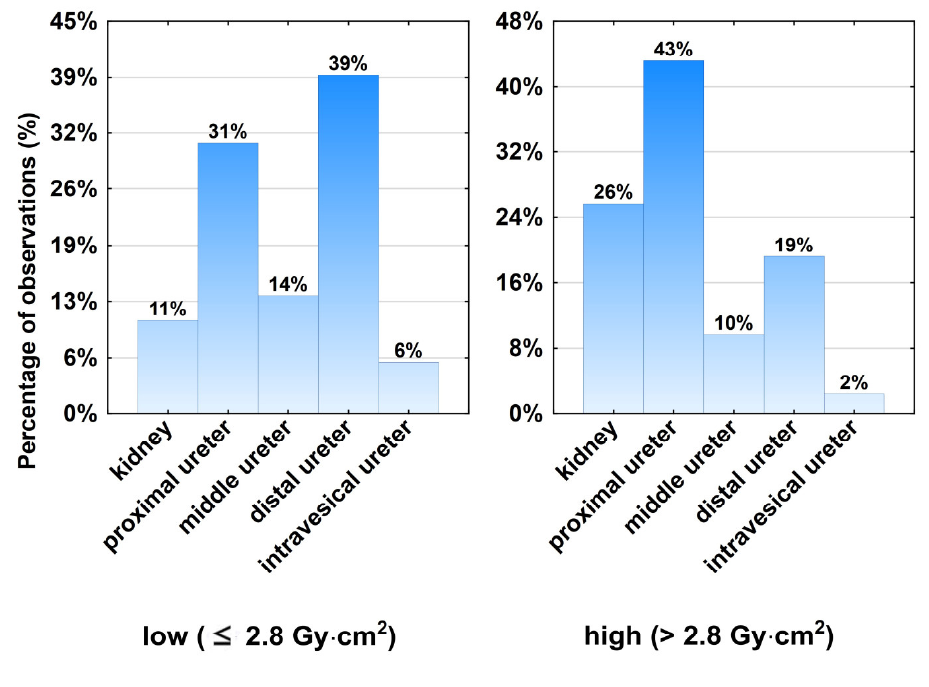
Figure 2. Distribution of stone location on ureterorenoscopy and its relation to lower and increased radiation exposures.